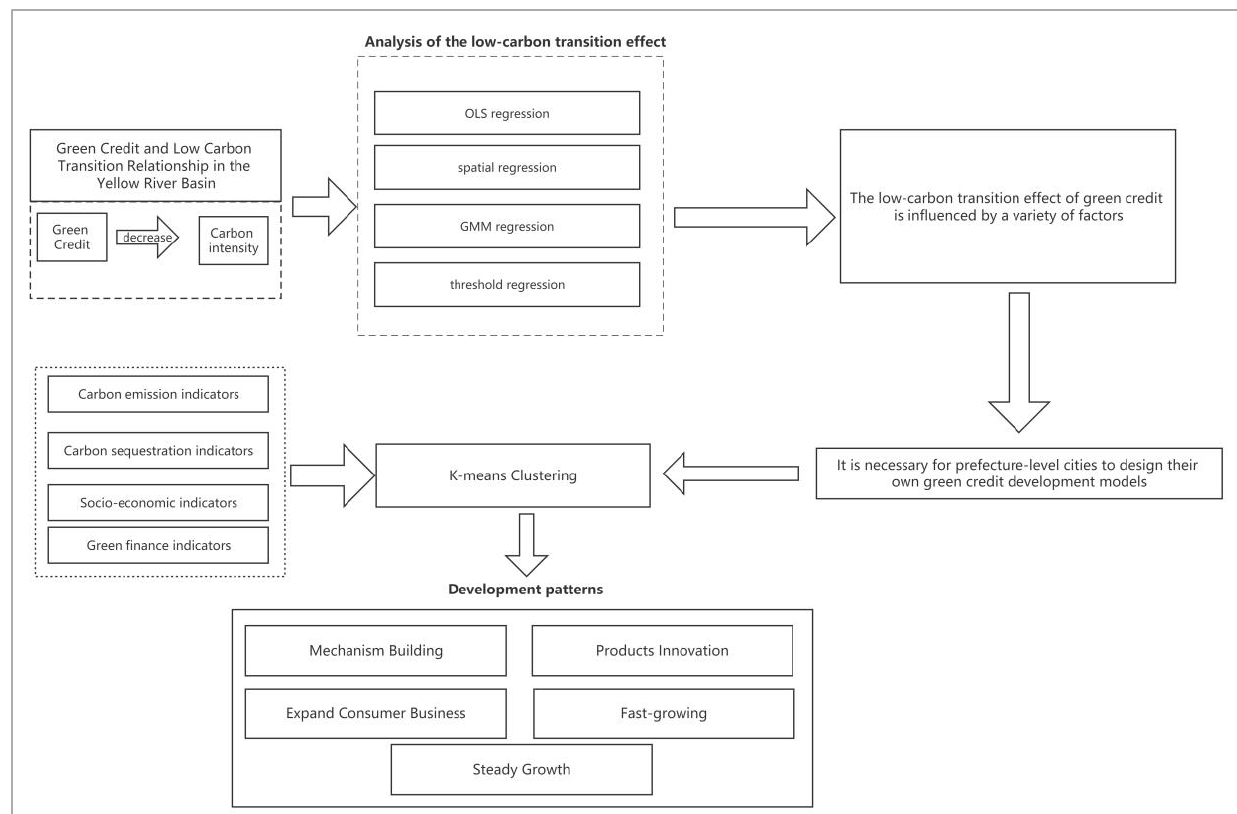
Figure 2. Research framework.